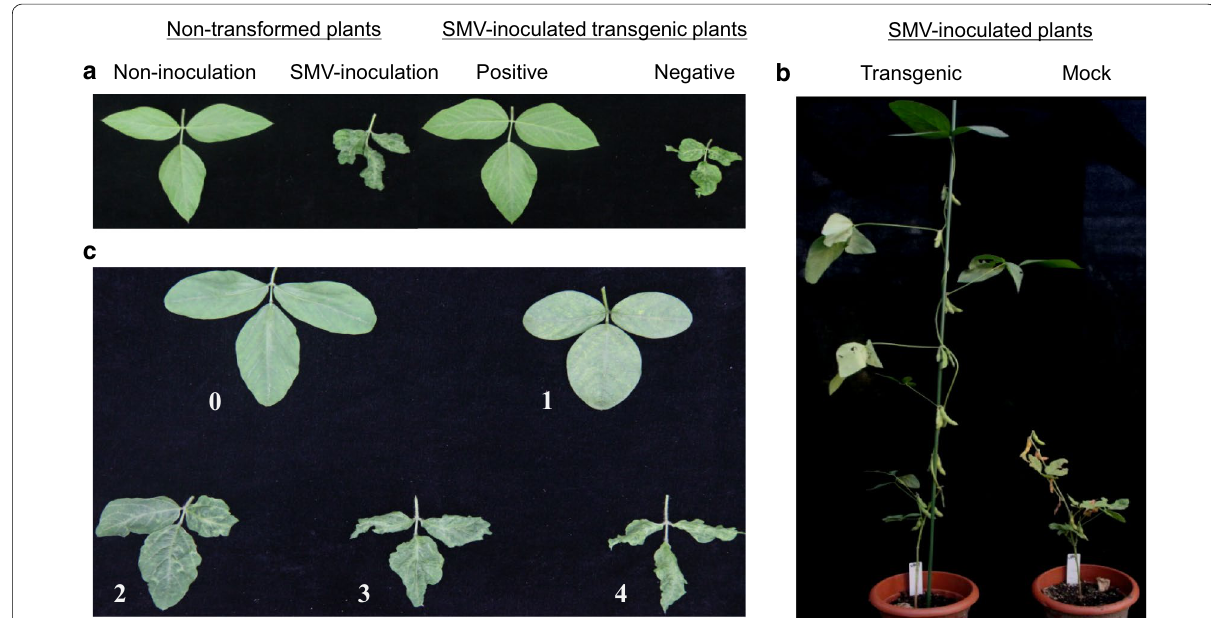
Fig. 4 Symptoms of T 1 plants after inoculating SMV-SC15 and disease rating classification. a Symptoms on the V4 leaves. b Response of T 1 transformed plants and non-transgenic plants in 8 weeks after inoculation with SMV. c SMV disease rating was classified to five (0–4) levels